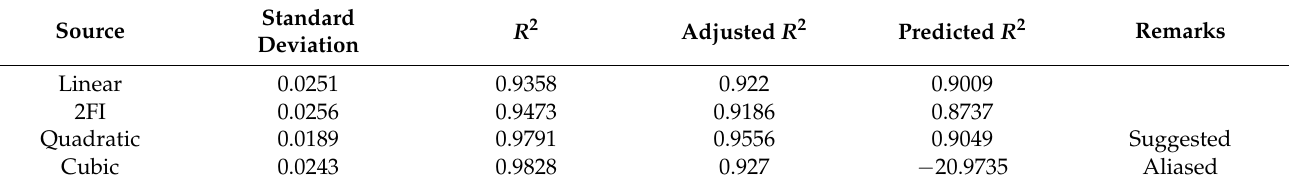
Table 5. Fit summary output